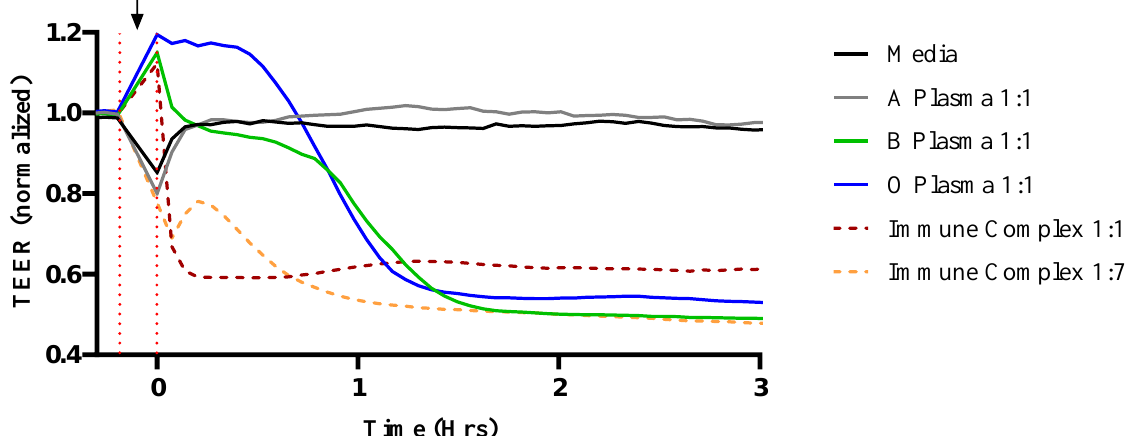
Figure 1. ABO mismatched plasma and IC cause endothelial barrier disruption. An illustration of type A HPAEC; EC were plated on gold electrode arrays and grown to confluency. Cells were treated with ABO identical and non-identical plasma as well as varying concentrations of IC, and transendothelial resistance (TEER) was measured over 3 h by Electric Cell-substrate Impedance Sensing System (ECIS). Resistance was normalized to the values before treatment. Dotted red bars and arrow indicate when measurement was paused and treatments were added.